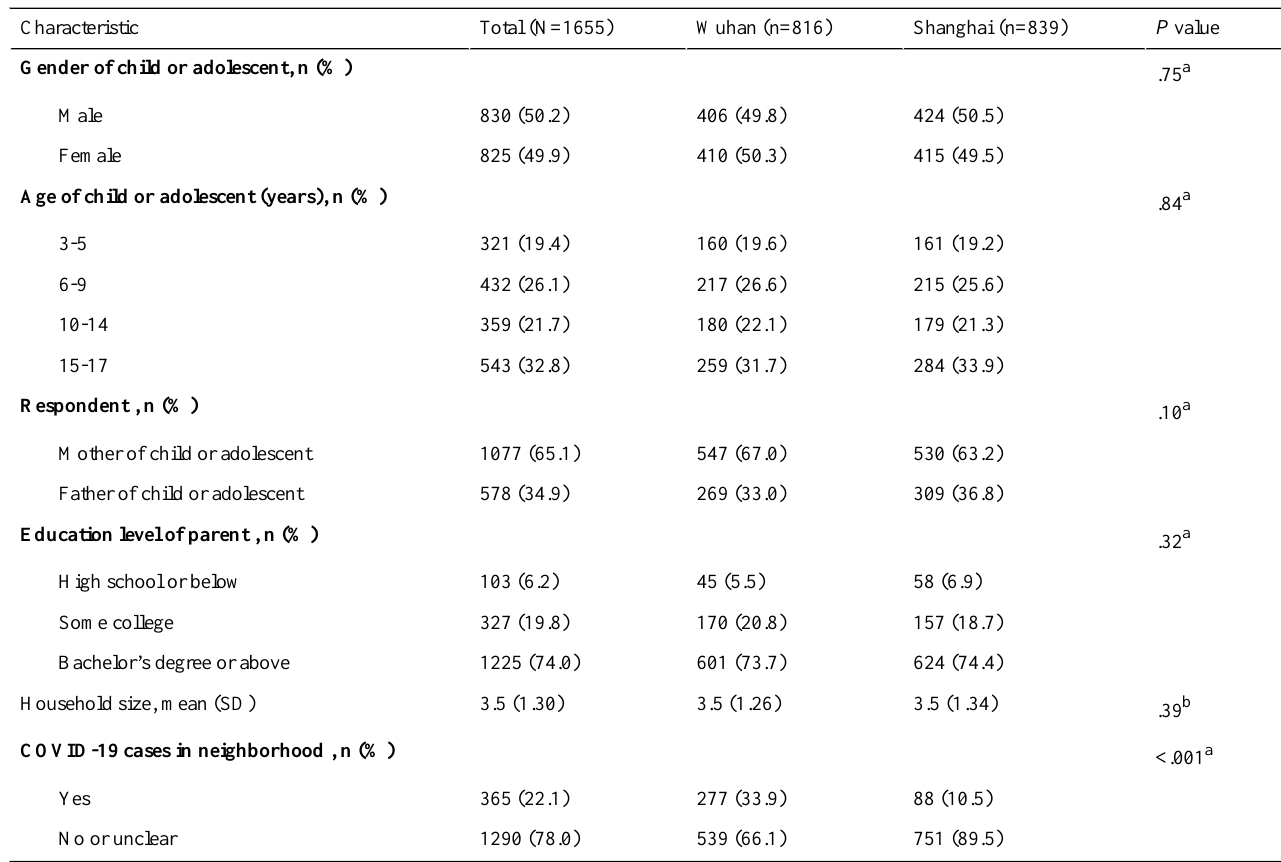
Table 1. Characteristics of respondents in Wuhan and Shanghai during the COVID-19 epidemic, March 2020.